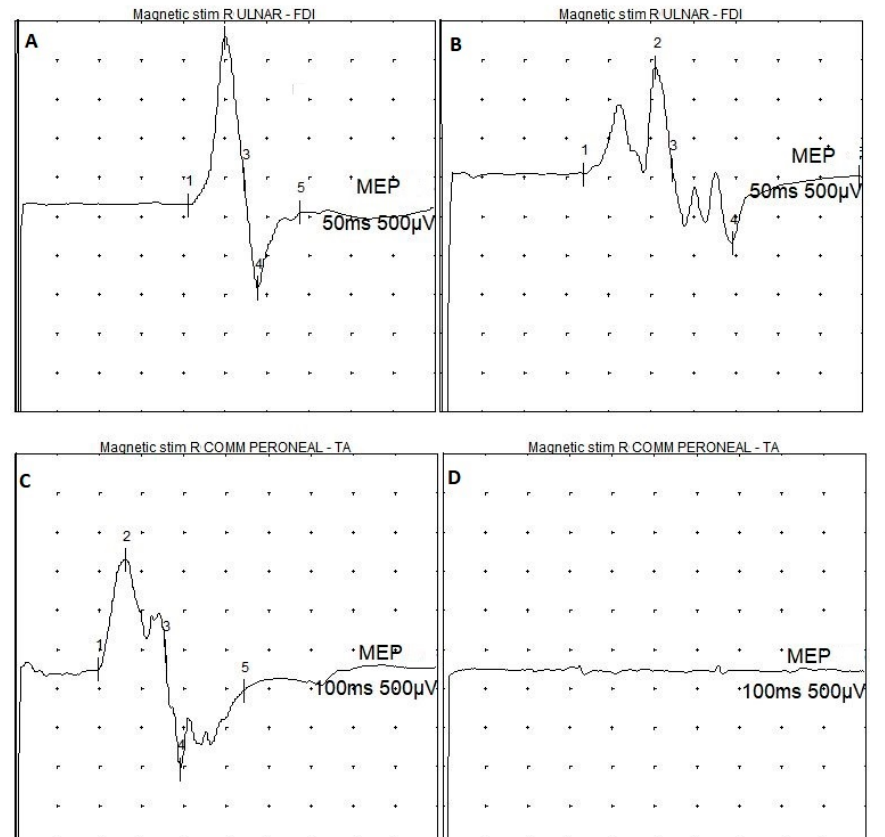
Figure 1. Examples of MEPs recordings in MPS patients. ( A ) normal MEP from the upper limb; ( B ) MEP with reduced amplitude and polyphasic shape from the upper limb; ( C ) normal MEP from the lower limb; ( D ) absence of transcranially-induced motor response from the lower limb. MPS = mucopolysaccharidosis; Magnetic stim = transcranial magnetic stimulation; R ULNAR = right ulnar nerve; R COMM PERONEAL = right common peroneal nerve; FDI = first dorsal interosseous muscle; TA = tibialis anterior muscle; MEP = motor evoked potential; 50 ms = temporal resolution of the screen (sweep) for upper limb recordings; 100 ms = temporal resolution of the screen (sweep) for lower limb recordings; 500 µV = amplification factor of the screen.